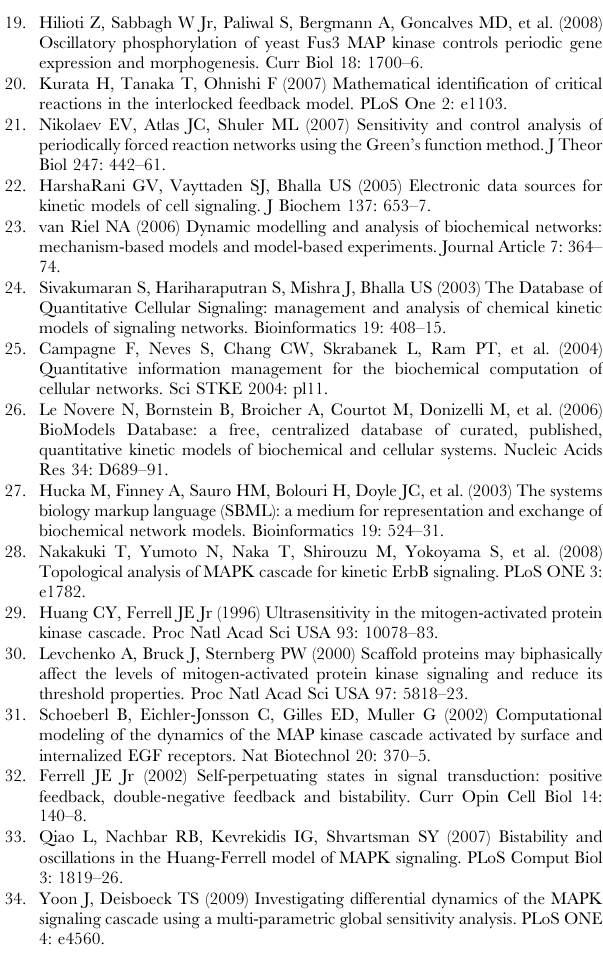
Table S1 Definitions of major elements of reaction- based database. (DOC) Text S1 Data structure and unified format of reaction- based